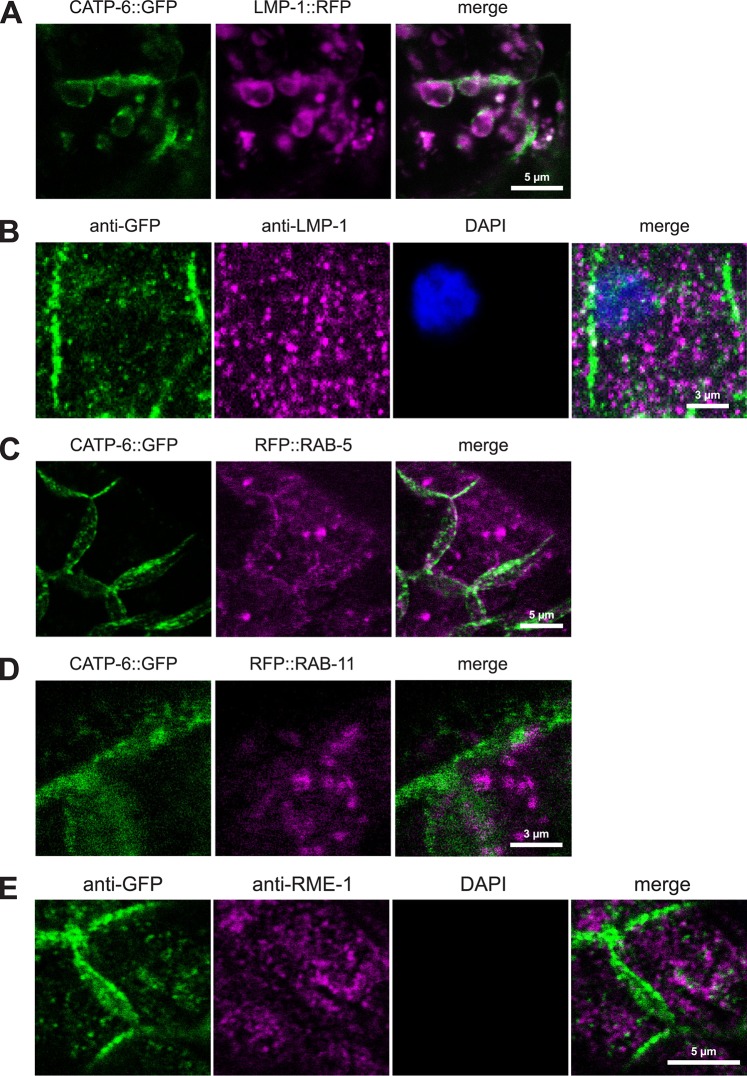
Subcellular localization of CATP-6 in the spermatheca.(A) Co-localization of native CATP-6::GFP vs. LMP-1::RFP in living spermatheca. catp-6(dx183[catp-6::gfp::3xFlag + loxP]) IV, Ex [Pcatp-6catp-6::gfp;Psth-1lmp-1::rfp;rol-6(d)]. (B) Immunostaining of native CATP-6::GFP vs. native LMP-1 in the spermatheca. catp-6(dx183[catp-6::gfp::3xFlag + loxP]) IV. (C-D) Co-localization of native CATP-6::GFP vs. RFP::RAB-5 and RFP::RAB-11 in living spermatheca. catp-6(dx183[catp-6::gfp::3xFlag + loxP]) IV, Ex [Pcatp-6catp-6::gfp;Psth-1rfp::rab-5;rol-6(d)] or Ex [Pcatp-6catp-6::gfp;Psth-1rfp::rab-11;rol-6(d)]. (E) Immunostaining of native CATP-6::GFP vs. native RME-1 in the spermatheca. catp-6(dx183[catp-6::gfp::3xFlag + loxP]) IV.